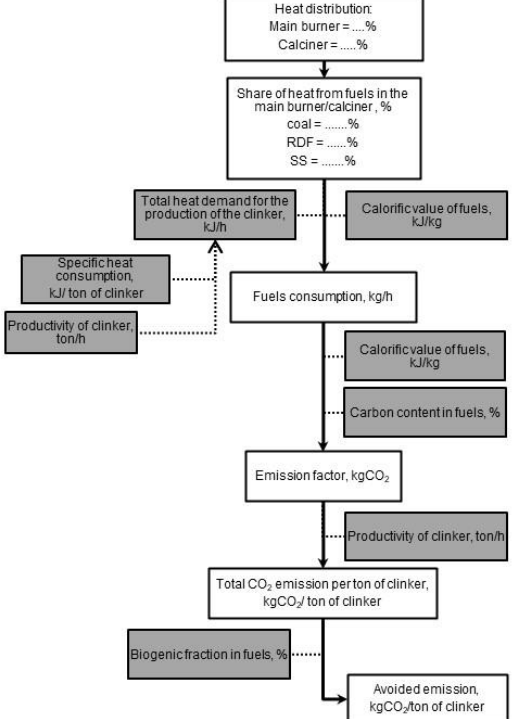
Figure 1. The algorithm to evaluate the CO 2 emissions from fuel combustion in the cement plant.